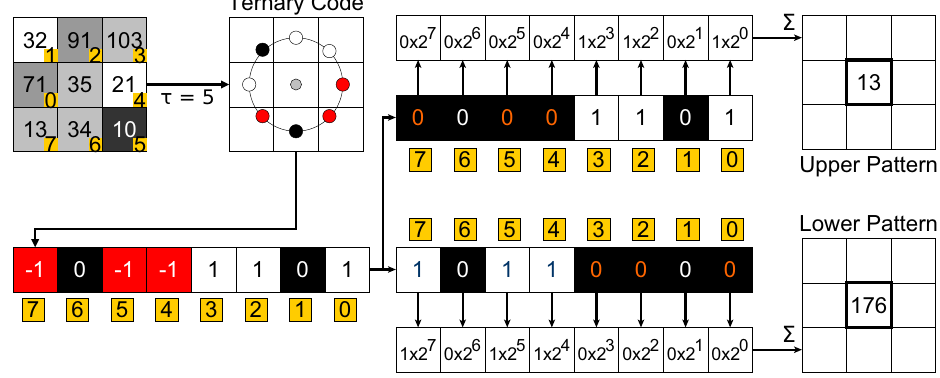
Figure 5. Illustration of the basic Local Ternary Pattern